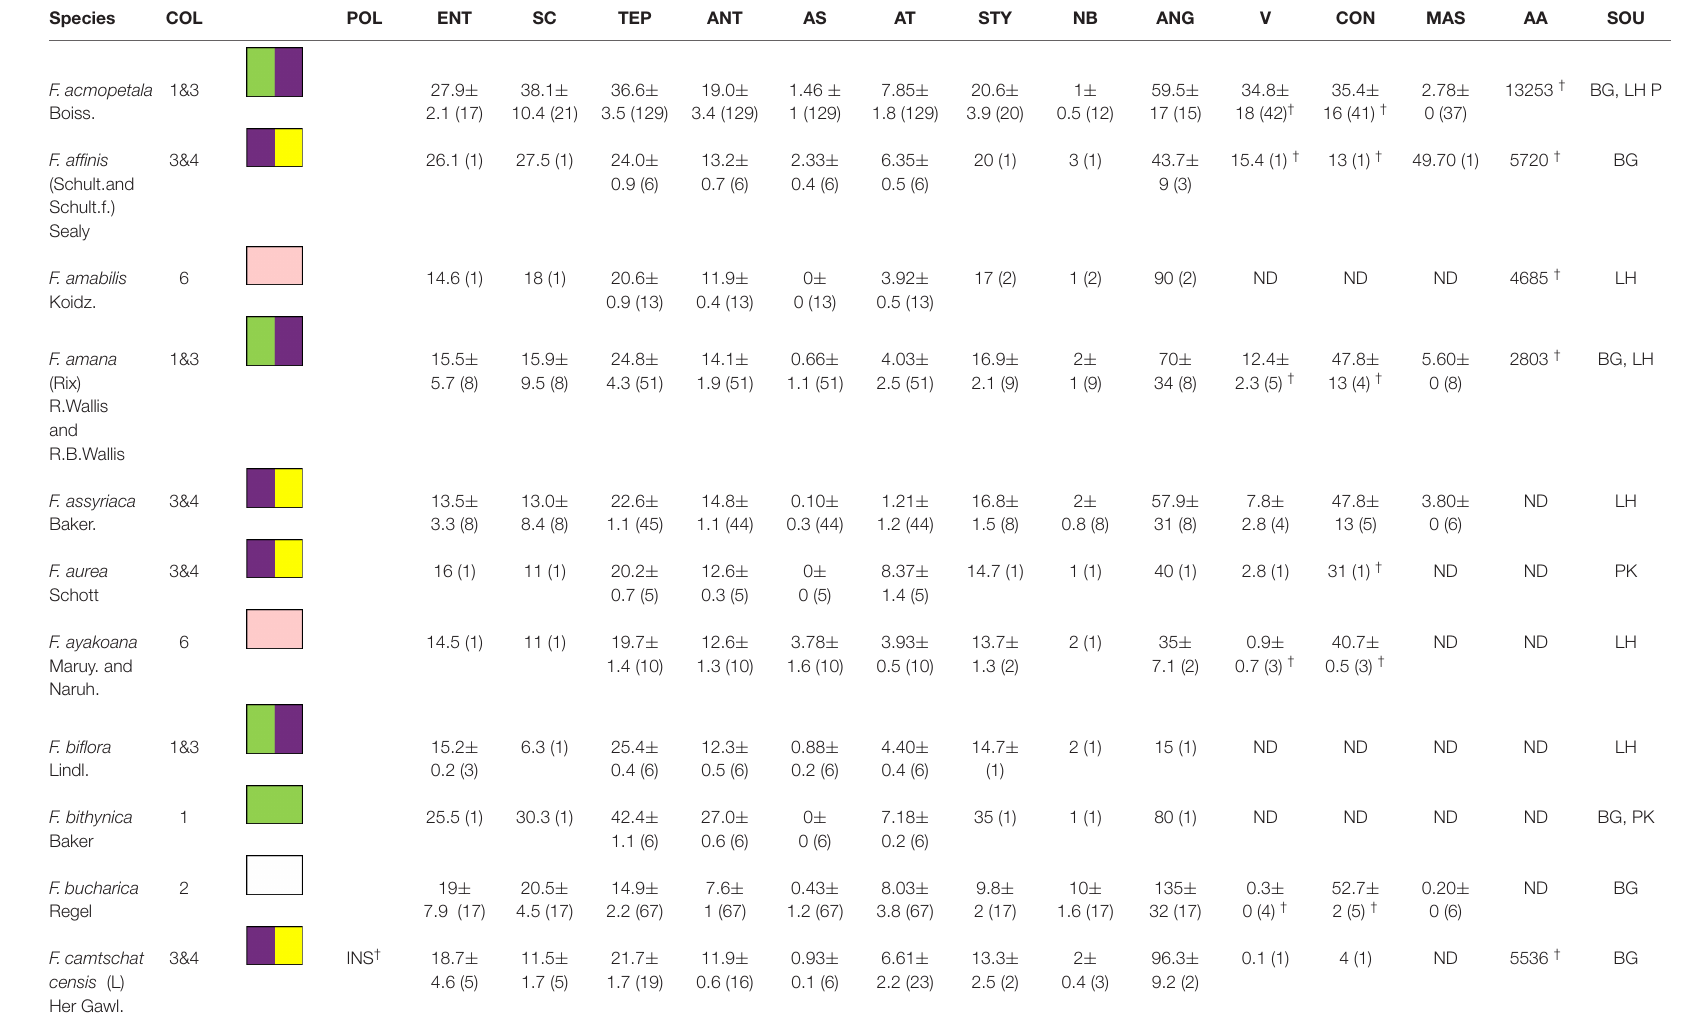
TABLE 1 | Investigated Fritillaria species, all flower measurements in millimetres ± standard deviation, values in () indicate number of measurements, † indicates values obtained from literature. Species COL POL ENT SC TEP ANT AS AT STY NB ANG V CON MAS AA